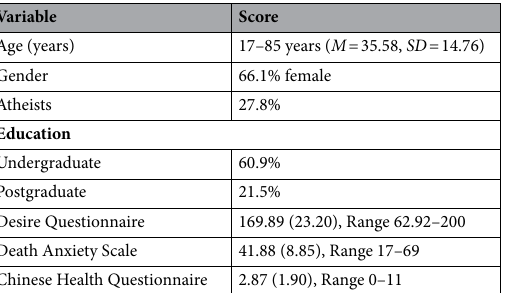
Table 5. Descriptive data: Sample characteristics, means and standard deviations of psychological measures ( N = 501). For continuous variables, the mean is followed by the standard deviation in